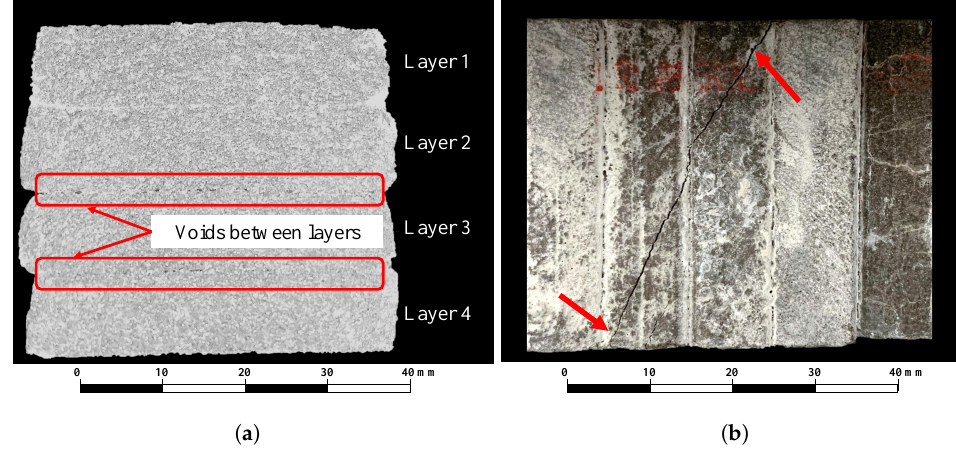
Figure 12. ( a ) Observation of voids between layers in a 3D-printed UHPC specimen, and ( b ) specimen with a crack that did not propagate through the